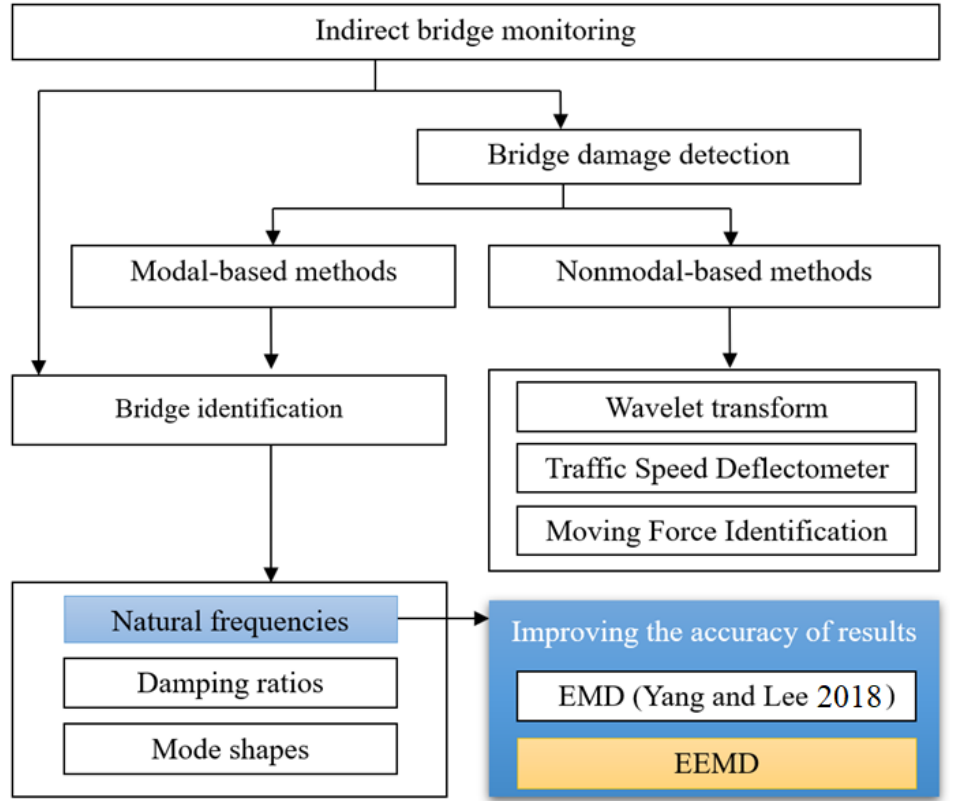
Figure 1. The contribution of this study to the state of the art (EMD: empirical mode decomposition, EEMD: ensemble empirical mode decomposition).